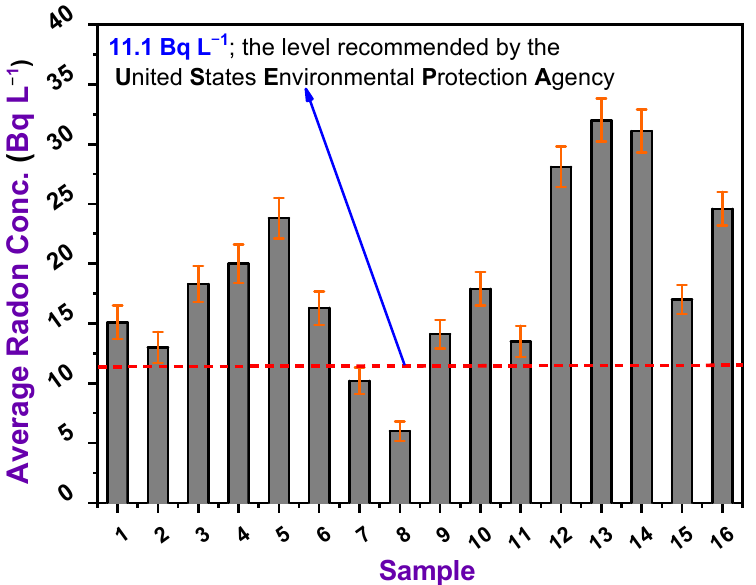
Figure 3. Variations of the mean radon activity concentrations for the sixteen water samples, compared to the USEPA parametric value.